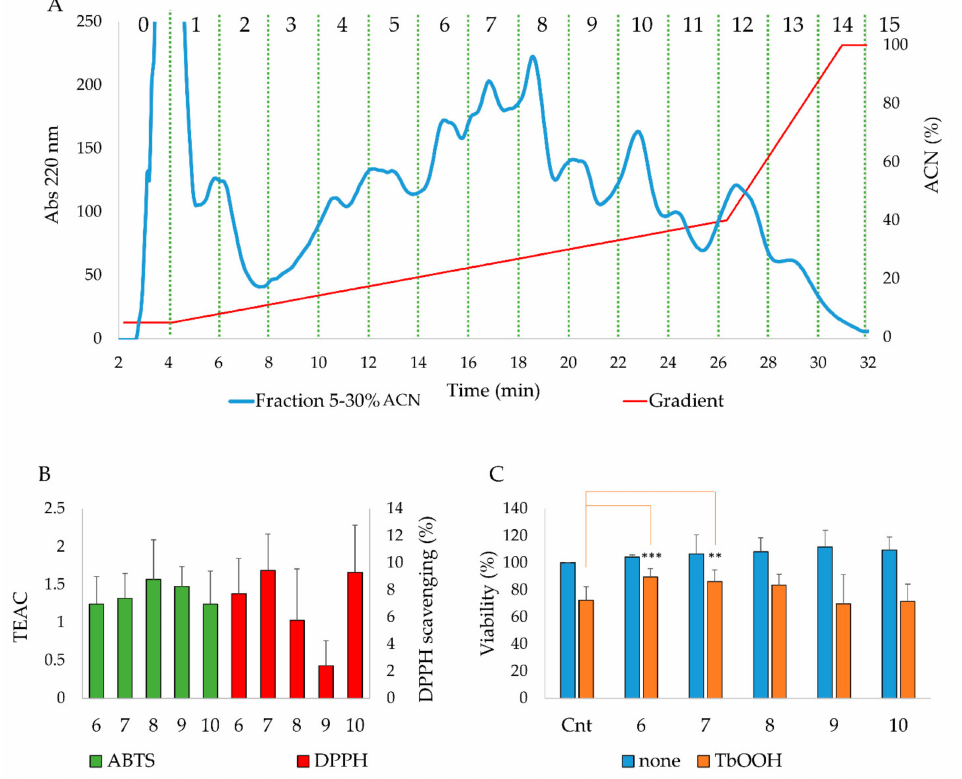
Figure 1. (A )Purification of the 5–30% ACN fraction with RP-HPLC. Fractions were collected every 2 min. ( B ) Analysis of antioxidant capacity of the purified fractions in vitro with 2,2 (cid:48) -azinobis(3- ethylbenzo-thiazoline 6-sulfonate) (ABTS) (green) and 1,1-diphenyl-2-picrylhydrazyl (DPPH)